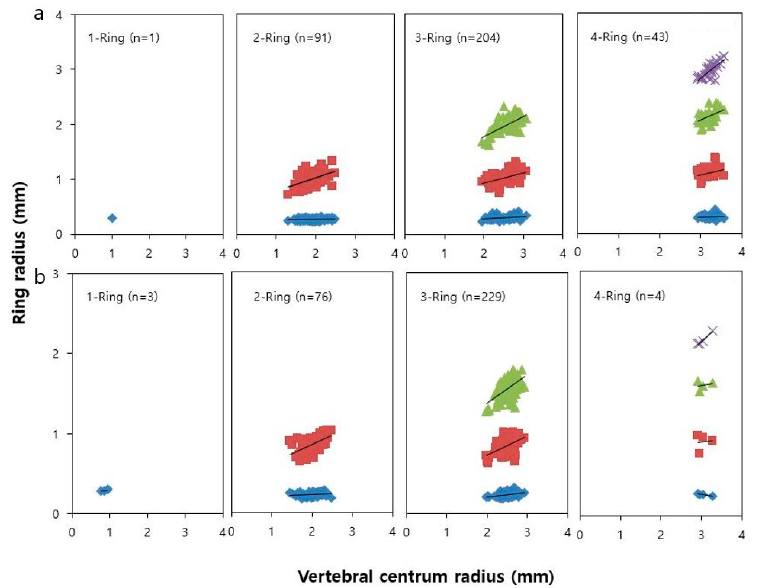
Figure 6. Relationship between vertebral centrum radius and growth ring radius for ( a ) female and ( b ) male specimens of Okamejei kenojei collected from the West Sea of South Korea.